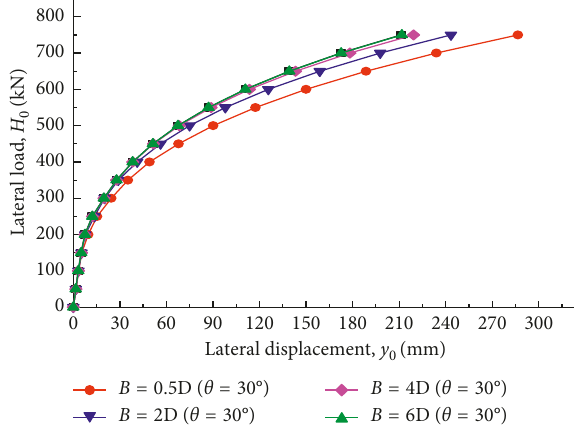
Figure 15: Lateral load-deflection curves for θ normalized distance of pile at pile head.